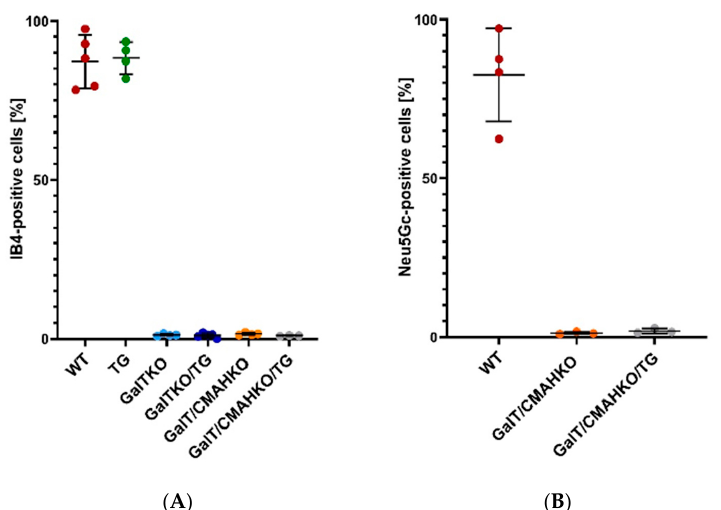
Figure 2. Phenotypical analysis of GGTA1 and CMAH inactivation. Results of surface presence of xenoantigens α -1,3-Gal ( A ) and Neu5Gc ( B ) on WT and genetically modified porcine chondrocytes by flow cytometry. Data values are given relative to total cell number, n ≥